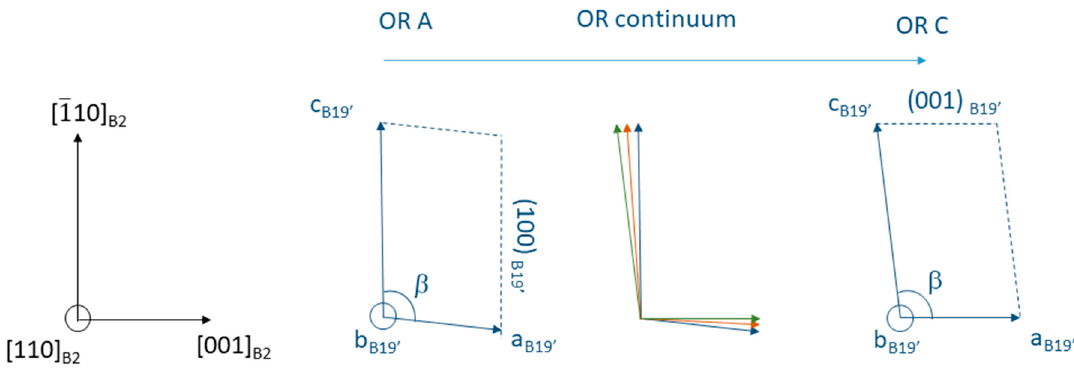
Figure 11. Schematic representation of the OR A, ORC, and its continuum A-C.